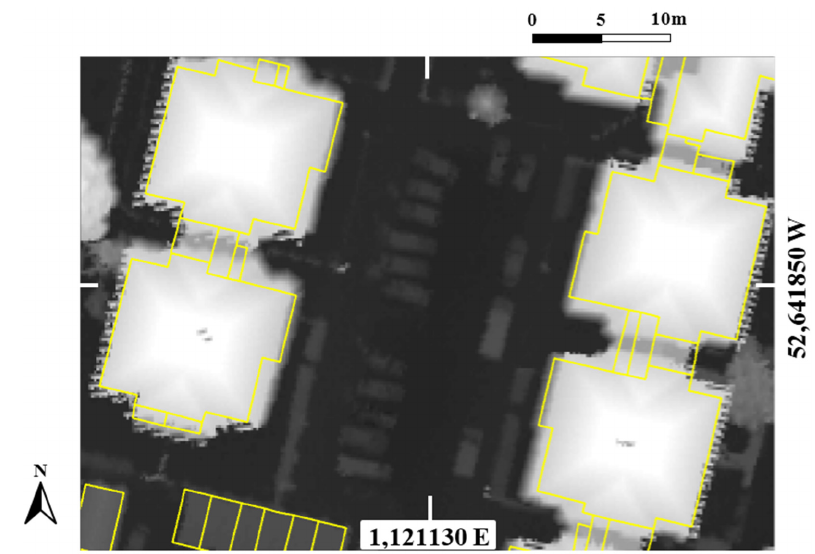
Figure 4. Overlay of cadastral building outlines and height data (raster DSM derived from LiDAR data), Leicester test site ( cf. Table 1). Building outlines: © Crown copyright and database right 2012 Ordnance Survey licence number 100042840, LiDAR data: Copyright © Bluesky International Ltd.